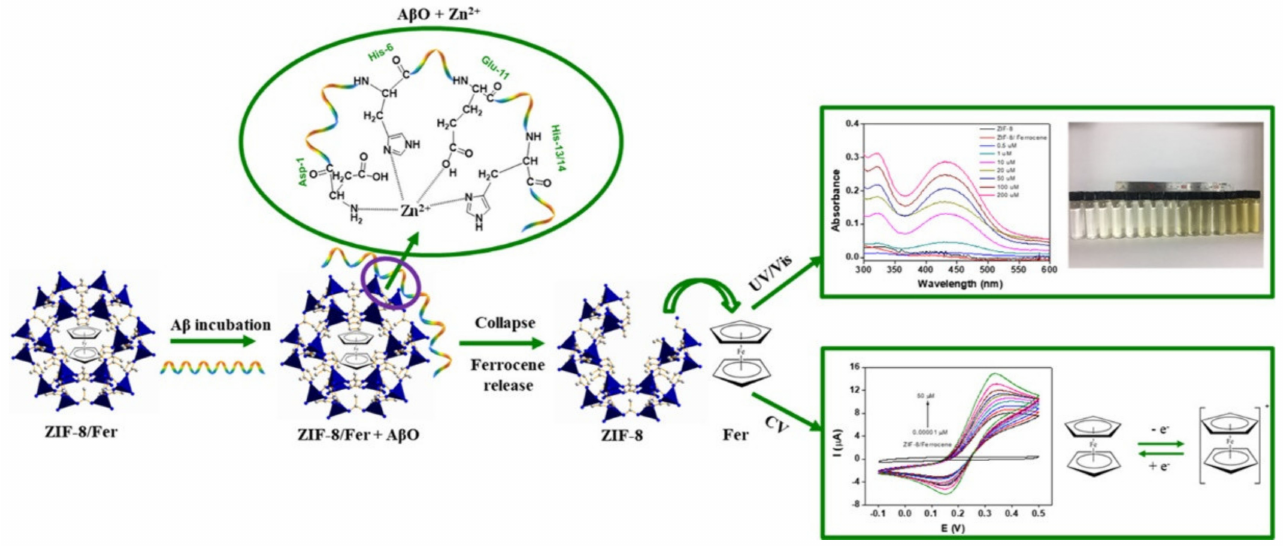
Figure 2. Nanoscale ZIF-8/Fer for A β O sensing utilizing electrochemical and optical methods. Adapted from ref [21], with permission from Copyright © 2019, American Chemical